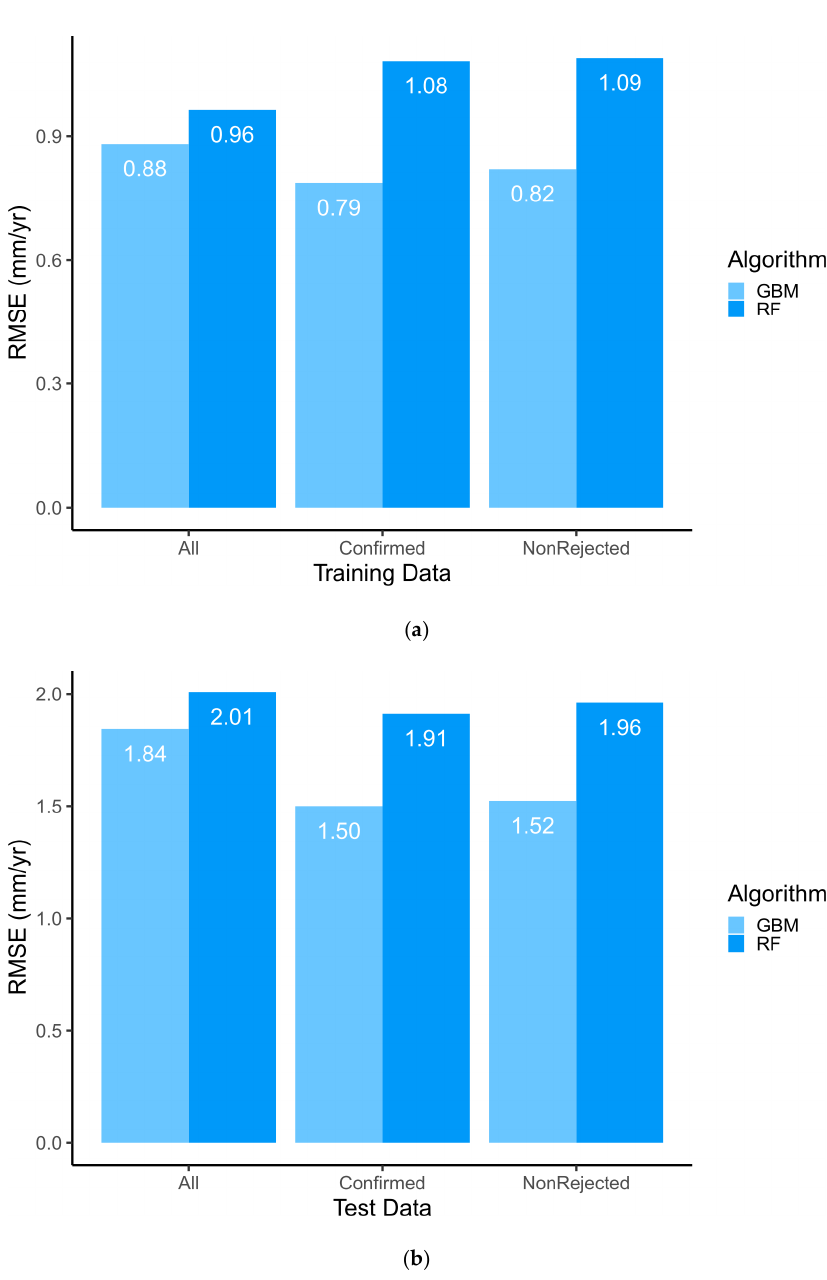
Figure 6. Comparison between parameter selections: ( a ) training data and ( b ) test data (lower is better).